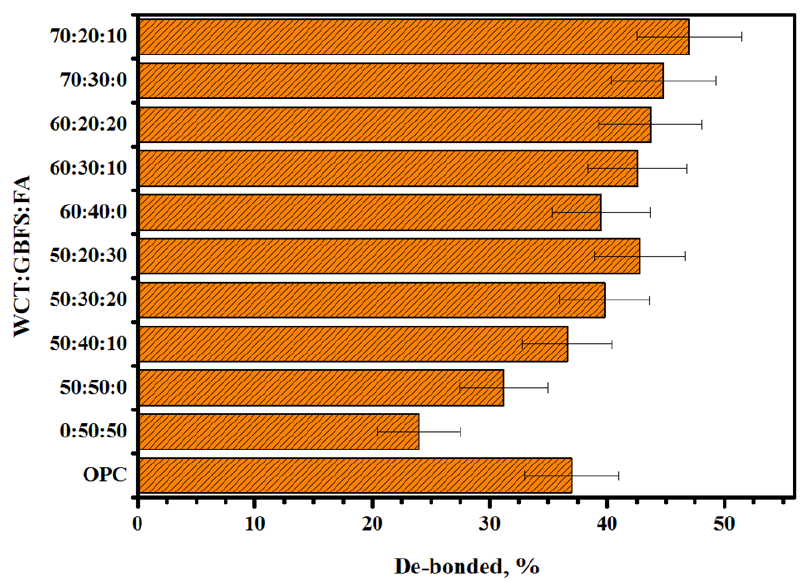
Figure 10. Effects of various WCT:GBFS:FA on the de-bonded percentage of the prepared GPMs.